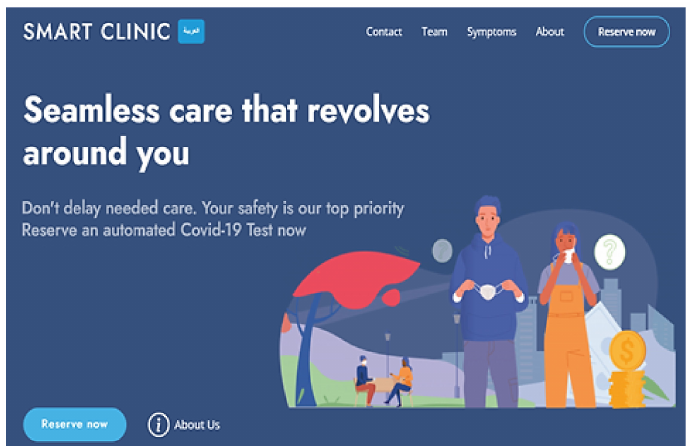
Figure 4. The front page of the proposed clinic’s website.